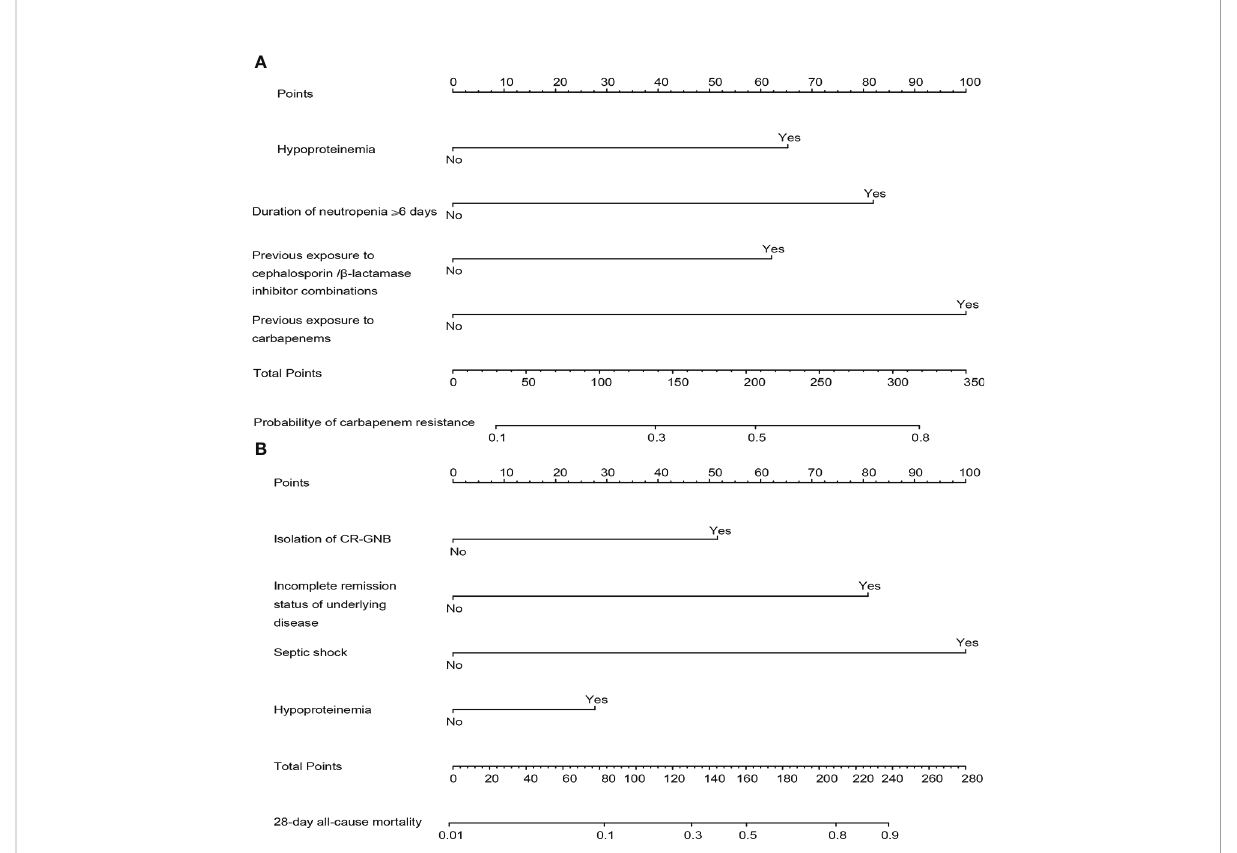
FIGURE 4 The constructed nomograms for predicting risk probability of carbapenem resistance and 28-day all-cause mortality in gram-negative bacteremia among patients with hematological diseases, abbreviated as the carbapenem resistance nomogram (A) and the prognosis nomogram (B) . Each predictor has corresponding points, and the total score for an individual patient could be obtained by summing up all scores. CR-GNB, carbapenem-resistant gram-negative